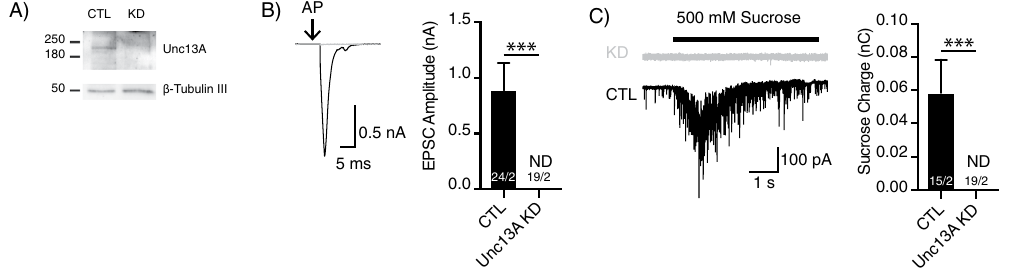
Figure 5. Loss of function by knockdown of Unc13A in BIHi001. ( A) Immunoblot of Unc13A protein levels of iNs transduced with a shRNA against Unc13A or a control construct. Signal at 200 kDa corresponds to the expected Unc13A, and the signal at 50 kDa to β -Tubulin. Western blot images have been cropped for presentation. Full size image are presented in Supplementary Fig. S1. ( B) Exemplary traces of AP-evoked EPSCs (left) and average EPSC amplitudes (right). ( C) Exemplary traces of the currents evoked by 500 mM hypertonic sucrose solution (left) and average sizes of the RRP charges (right) in KD and control (CTL) conditions. (ND, not detectable). AP artefacts were blanked and are indicated by black arrows. The numbers of neurons and independent cultures analysed are shown within the bars. Data are expressed as mean ±